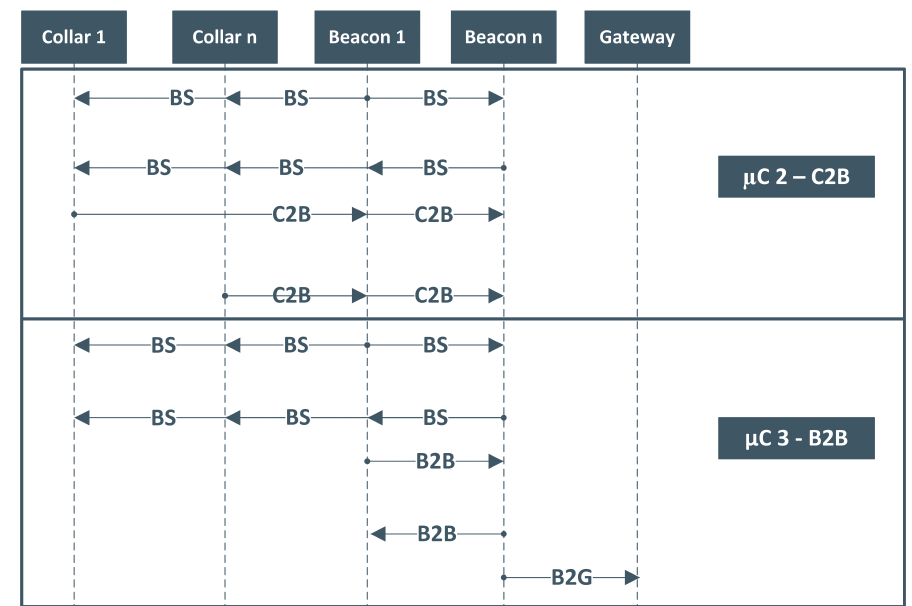
Figure 6. Message sequence chart of a µC type 2 and